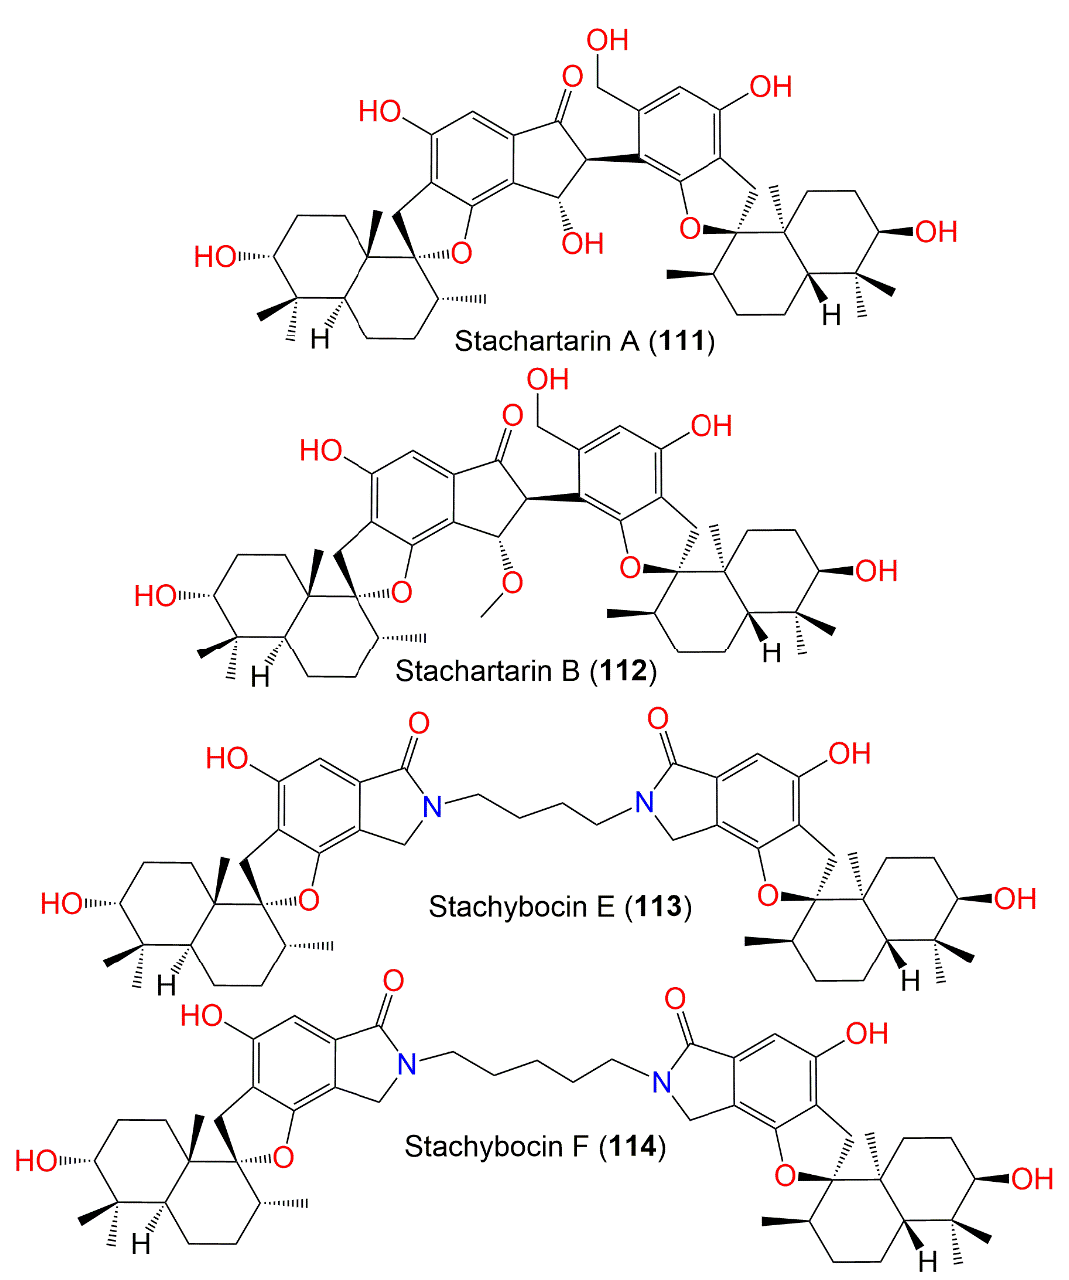
Figure 15. Structures of dimeric phenylspirodrimane derivatives ( 111 – 114 ) reported from S . chartarum .